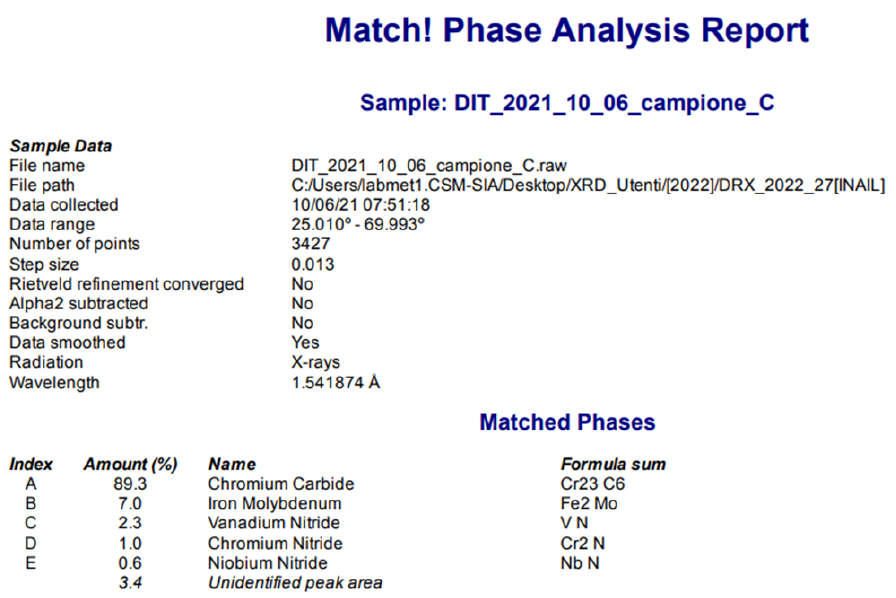
Figure A7. Failed crept cross-weld specimen 91-HAZ-3-6 600 °C 99 MPa 4280 h (sample C). Sample data and matched phases.